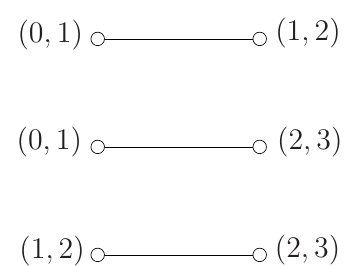
Figure 1: Scheduling 3 burgers for a 2-burger